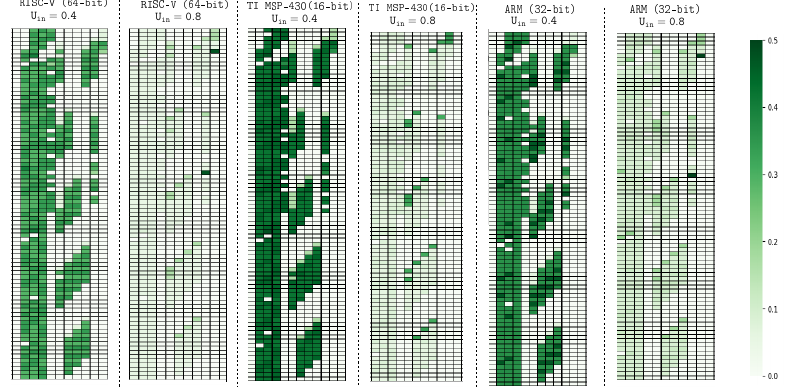
Figure 13: SuccessScore of vulnerable instructions (AES-128 (LookUp Table)) after inserting counter- measures on three processors with U in 0.4 and 0.8. Each cell represents an instruction.